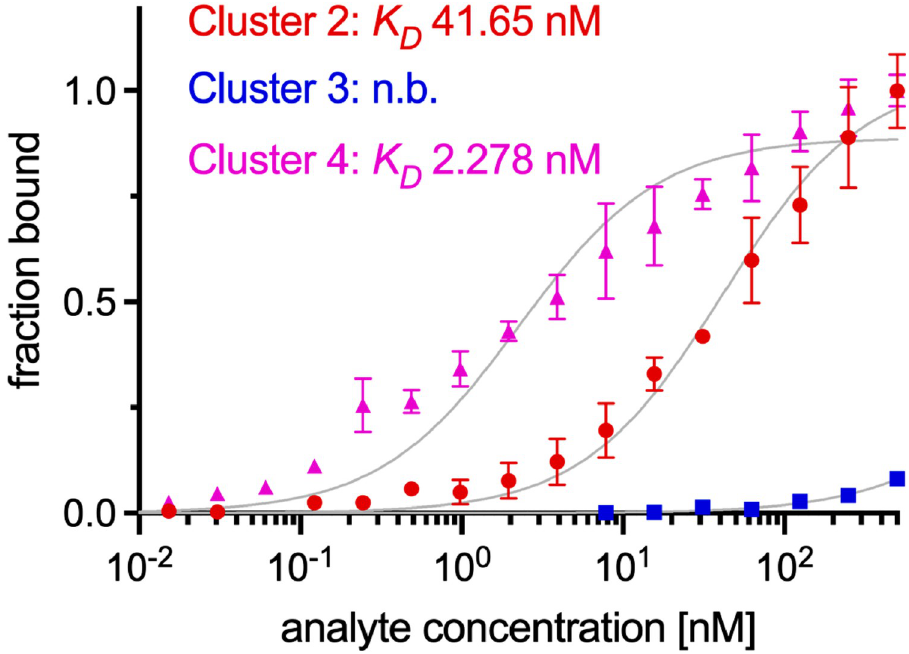
Fig 5. Solid-phase binding assay of PMT to clusters 2, 3, and 4 of LRP1. Graph depicts the binding curves of cluster 2 (dots), 3 (squares), and 4 (triangles) to plates coated with His-PMT. The equilibrium-binding affinity ( K presented inside the graph. Data are shown as mean with